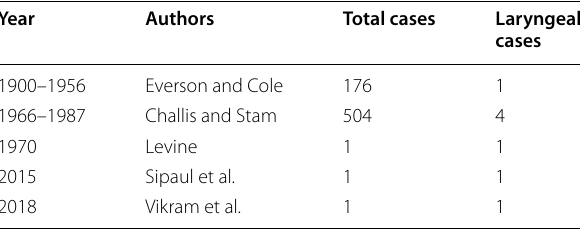
Table 1 Total laryngeal cancer regression cases